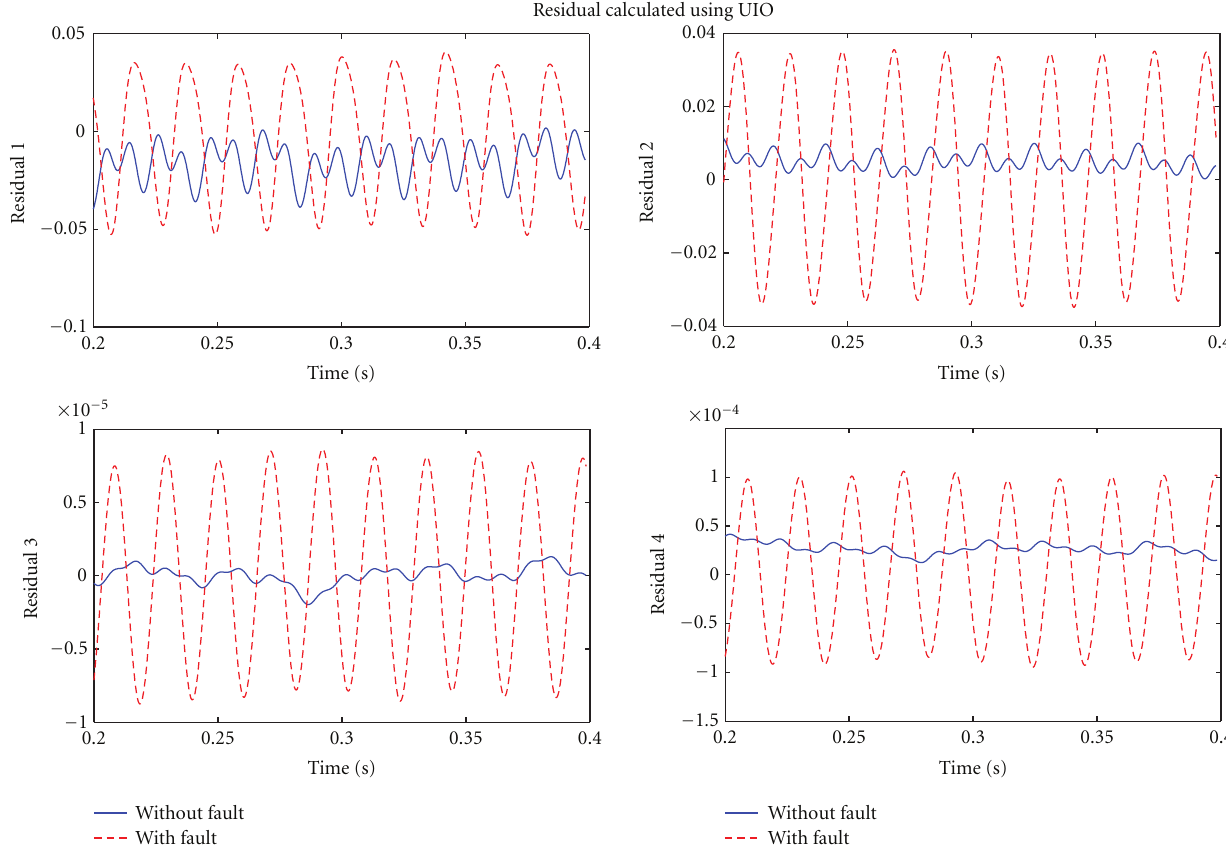
Figure 10: Residual generated by